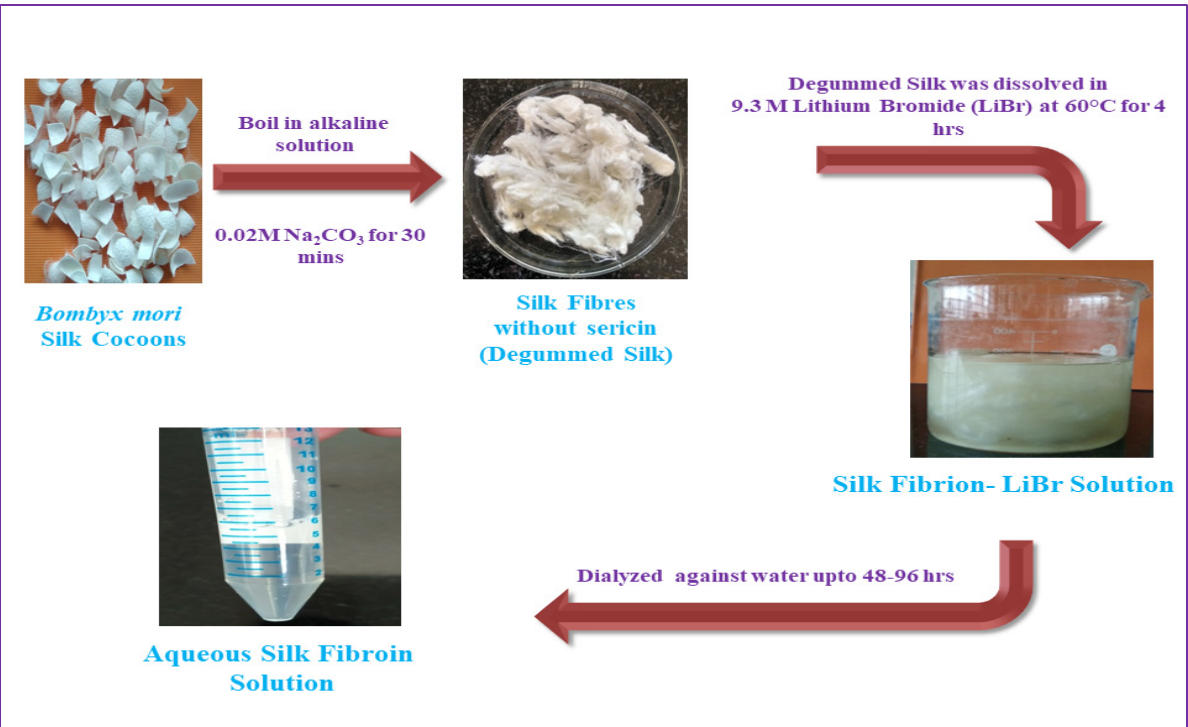
Figure 2. Processing of SF.